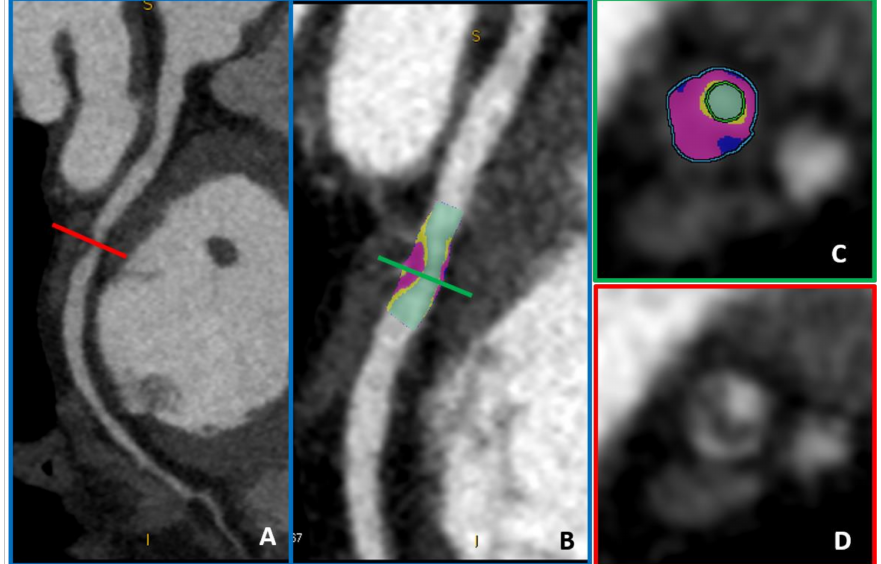
Figure 4. A coronary plaque with moderate lumen stenosis (50–70% stenosis) (panels ( A , D )) can be further analyzed by advanced plaque-volume quantification (panels ( B , C )). In light blue, low-attenuation plaque (HU < 30) is automatically recognized and quantified, while fibro-fatty plaque volume is represented in purple (HU <